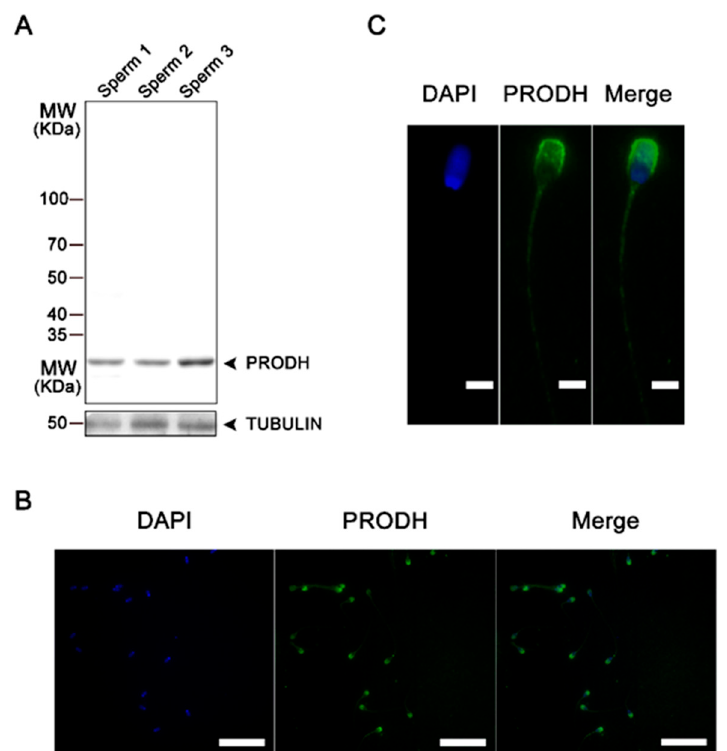
Figure 6. Expression of proline dehydrogenase (PRODH) in boar sperm. ( A ) Identification of PRODH in sperm by Western blot. Protein samples were obtained from three di ff erent boars. ( B ) Images of the immunofluorescent localization of PRODH in sperm at 400 × magnification. Scale bars represent 100 µ m. ( C ) Images of the immunofluorescent localization of PRODH in sperm at 1000 × magnification. Scale bars represent 20 µ m.